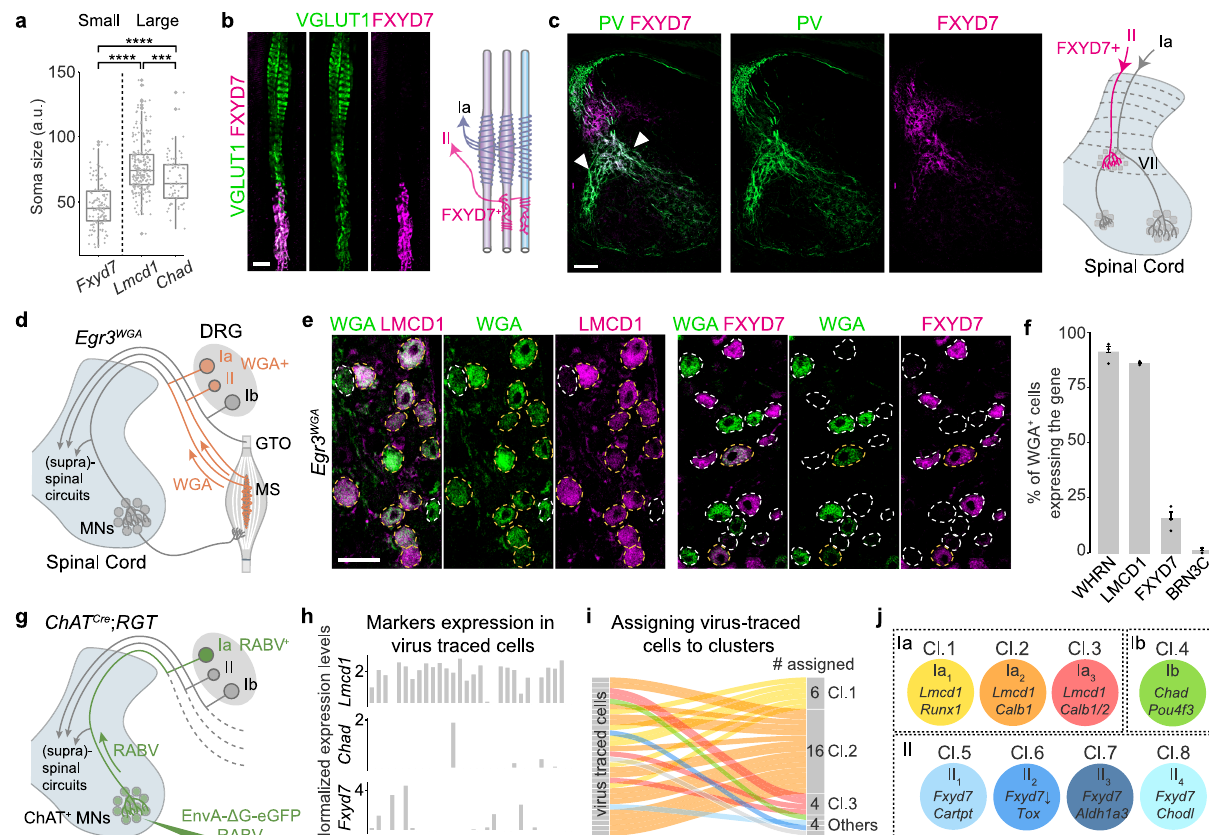
Fig. 2 Identi fi cation of the major PN types. a Quanti fi cation of cross-nucleus soma sizes of the three major PN populations depicted in box and whisker plot. Lower and upper hinges: fi rst and third quartiles; the horizontal line: median; the whiskers extend to the value no further than 1.5 * IQR from the hinge; large dots: outliers. Each dot represents a cell: Fxyd7 + PNs ( n = 124 cells), Lmcd1 + PNs ( n = 227 cells), Chad + PNs ( n = 69 cells). Two-tailed t -test, **** p < 0.0001, *** p < 0.001. b Longitudinal section of muscle spindle (MS) stained for VGLUT1 and FXYD7. Scale bar: 20 µ m. Right panel: schematic depiction of the fi nding. c Transverse section of P4 spinal cord stained for PV and FXYD7. Scale bar: 100 µ m. Right panel: schematic depiction of the fi nding. d Genetic strategy to label MS-innervating PNs in Egr3 WGA mice. e Representative image showing co-labeling of DRG neurons by WGA and LMCD1 or FXYD7 in DRG sections from P14 Egr3 WGA mice. Scale bar: 50 µ m. f Quanti fi cation of WGA + cells expressing WHRN, LMCD1, FXYD7, and BRN3C, respectively, in P14 brachial DRG ( n = 3 animals). Data are presented as mean ± SEM; dots represent values from individual animals. g Trans-monosynaptic rabies virus tracing strategy to label Ia-PNs in adult ChAT Cre ; RGT mice. h Bar plots showing that the majority of the rabies virus infected PNs express Lmcd1 but not Fxyd7 or Chad . i Assignment of virus infected PNs to the identi fi ed eight PN clusters based on their overall transcriptomic similarity. j A summary of correspondence between the known functional types of PNs and the cell clusters identi fi ed by scRNAseq. Source data are provided as a Source Data fi